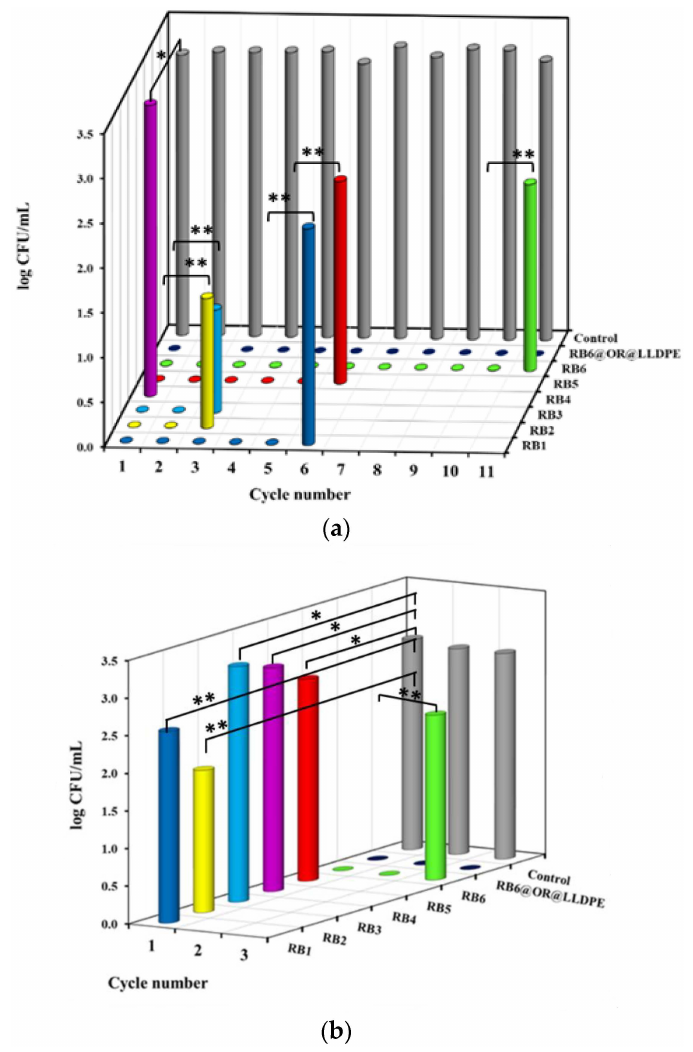
Figure 8. Antibacterial activity of RB1, RB2, RB3, RB4, RB5, RB6 and RB6@OR@LLDPE against E. coli under light illumination at fluence rate of 39.5 mW cm − 2 ( a ), and in the dark ( b ), at 25 ◦ C for 75 min. Control—untreated bacterial cells. Figures on the x-axis show the number of cycles. Control— E. coli after 75 min incubation. Results with no statistical difference are marked by one asterisk and statistically different results ( p < 0.05) are marked by two